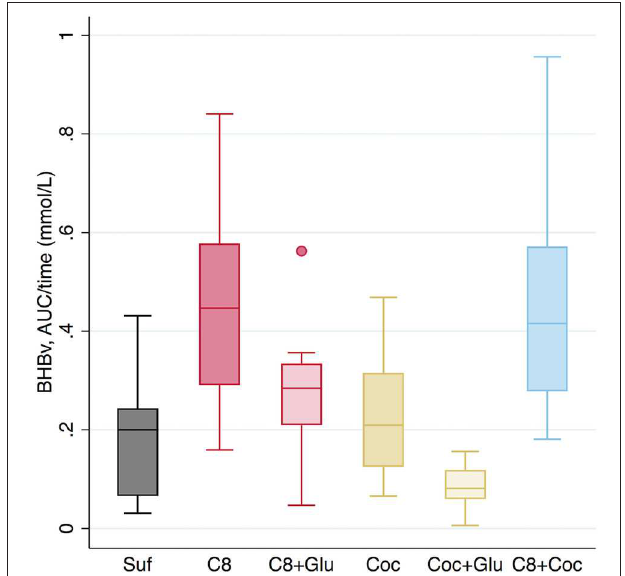
FIGURE 1 | BHBv concentrations in blood, AUC/time, (mmol/L) during T0–T240 (minutes). Values are absolute and not adjusted for baseline levels. Suf, Sunflower oil (30g); C8, Caprylic acid (20g) + Sunflower oil (10g); C8 + Glu, Caprylic acid (20g) + Sunflower oil (10g) + Glucose (50g); Coc, Coconut oil (30g); Coc + Glu, Coconut oil (30g) + Glucose (50g); C8 + Coc, Caprylic acid (20g) + Coconut oil (30g). BHBv, β -hydroxybutyrate in venous whole